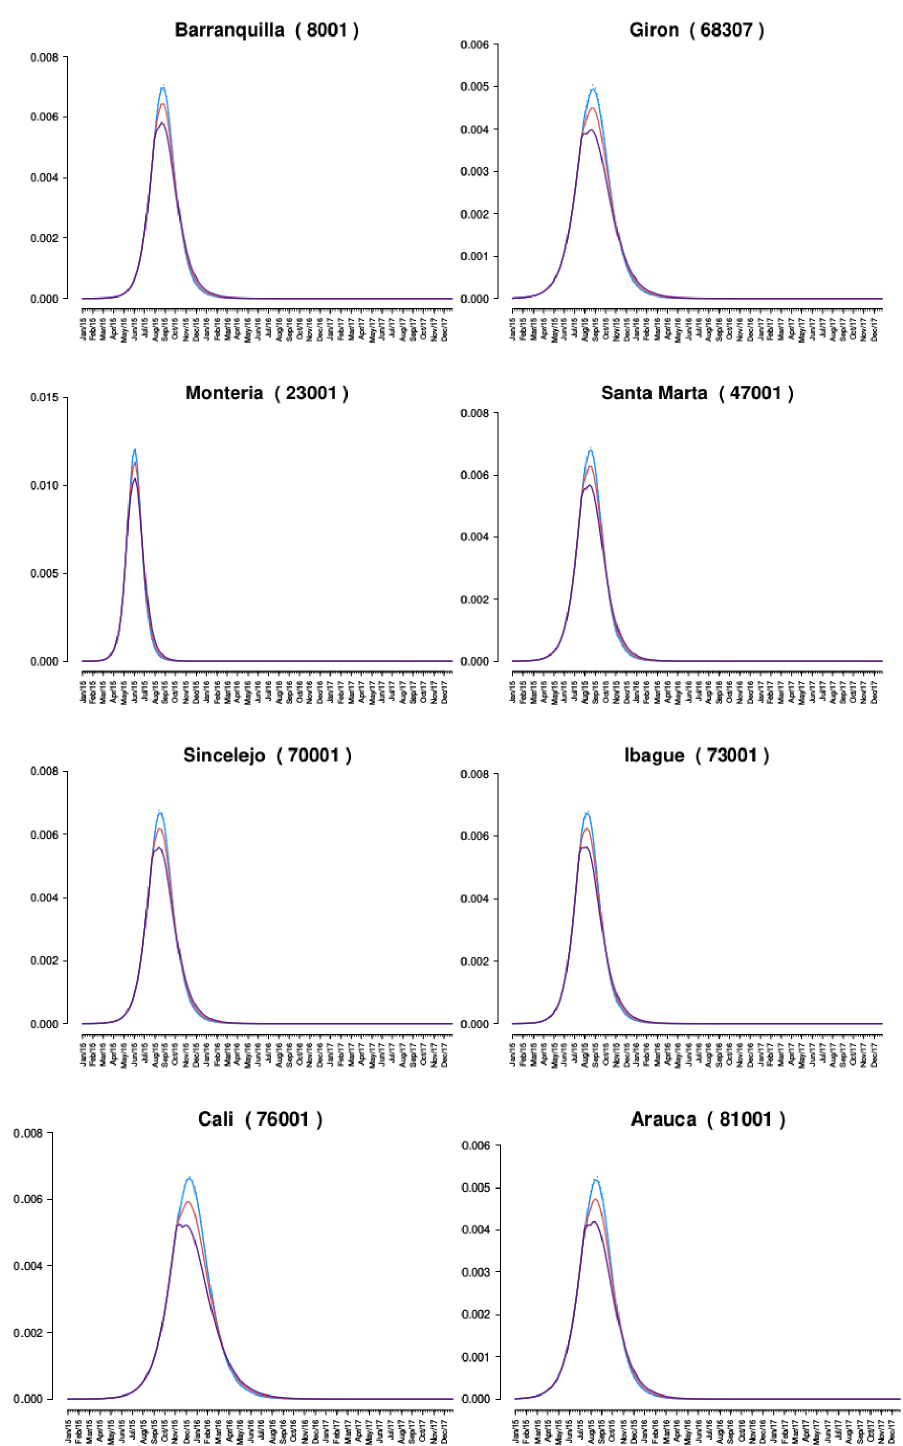
Fig 5. Comparison of the proportion of symptomatic infections of the best fit and the behavior of the epidemics when policies are implemented at th = 80%. Y-axis is a proportion (infected / at risk population), and the x-axis is time (in weeks). Best fit is dashed line, and policy 1,2, and 3 are colored blue, red, and purple, respectively.